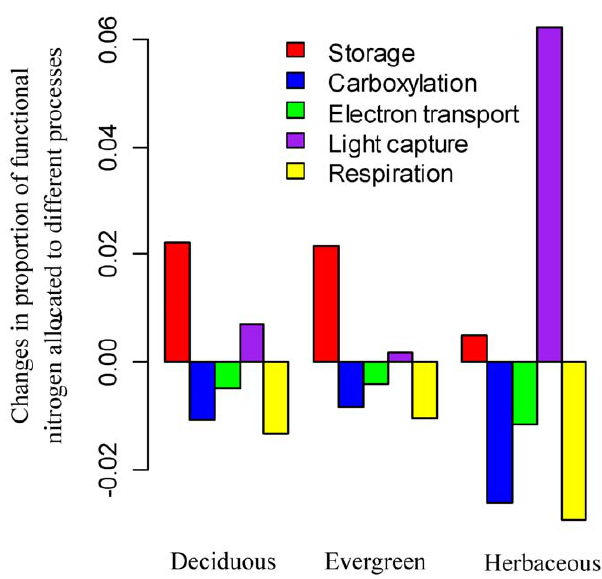
Figure 4. Acclimation of V c,max25 ( V c, max scaled to 25 6 C) to altered environmental conditions. The nitrogen allocation model is used to quantify the responses of V c,max25 to increased growing temperature (from 15 u C to 20 u C; labeled as ‘‘T’’ in the figure), increased CO 2 concentration (from 370 ppm to 570 ppm ; labeled as ‘‘CO 2 ’’ in the figure) and reduced radiation (from 800 to 400 m mol photon/ m 2 / s ; labeled as ‘‘RAD’’ in the figure) and their interactions for generic deciduous trees, evergreen trees, and herbaceous plants. The change of V c,max25 to environmental conditions in our model results from a decrease or an increase in nitrogen allocation to carboxylation. See Figure 2 for V c,max25 and nitrogen allocation coefficients for the control case. See Table 3 for main input parameters of the model.